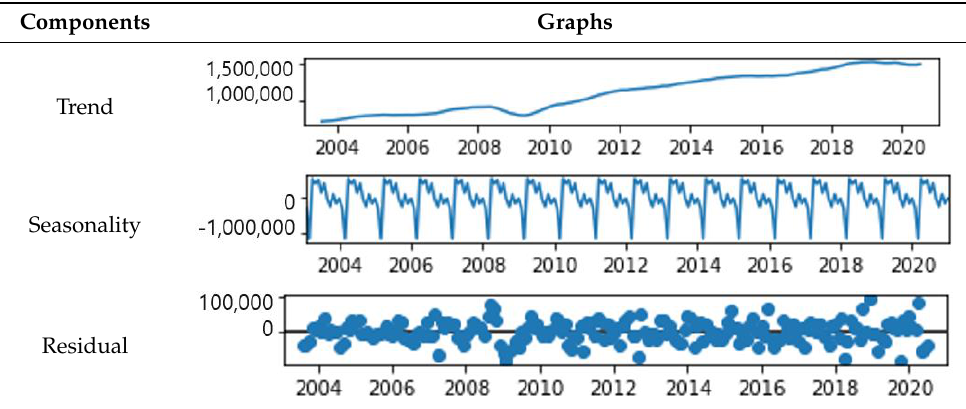
Table 1. Container volume components visualization.